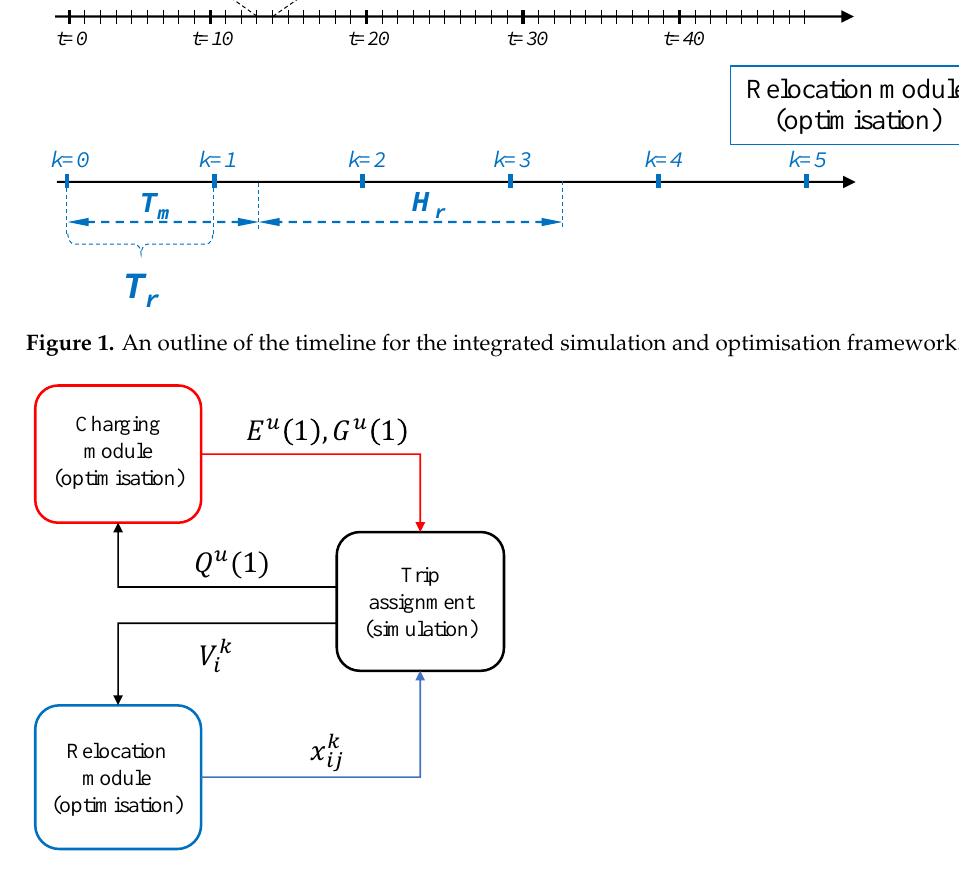
Figure 2. Functional architecture of the proposed